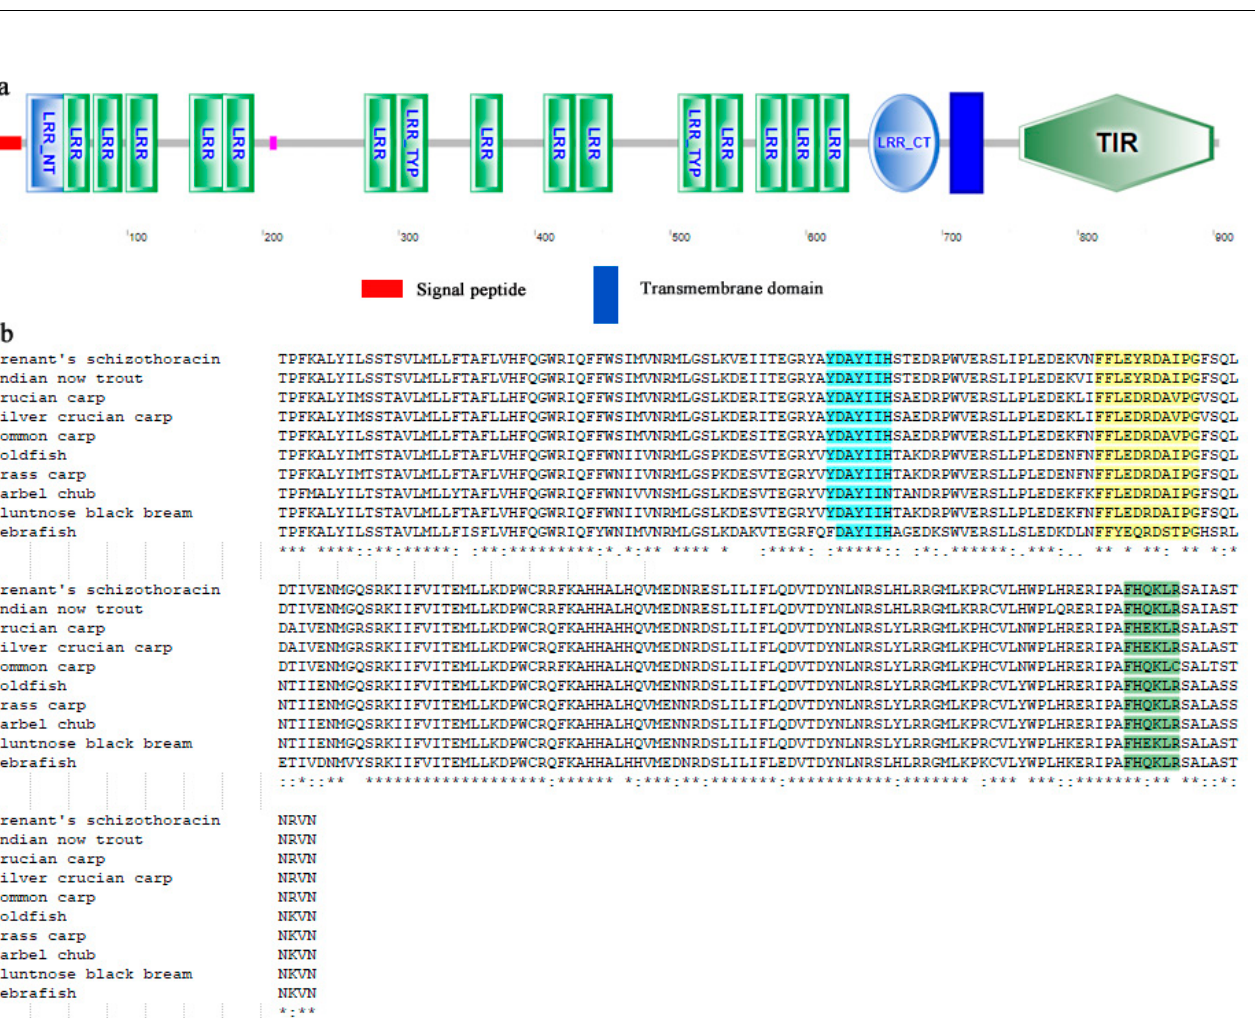
Figure 2. The predicted domain of Sp TLR3 protein by SMART programs. ( a ) Schematic representation of TLR3 domains predicted; ( b ) Multiple alignment of TLR3-TIR domains from different species. Snow trout (GenBank accession no. AGJ74274), Crucian carp (GenBank accession no. AGO57935), Silver crucian carp (GenBank accession no. AGR53439), Carp (GenBank accession no. AHE74142), Goldfish (GenBank accession no. ABC86865), Grass carp (GenBank accession no. ABI64155), Barbel chub (GenBank accession no.ALO75529), Bluntnose black bream (GenBank accession no. ABI83673) and Zebrafish (GenBank accession no. AAI07956). Asterisk (*), identical; colon (:), conserved; and dot (.), semi-conserved residues. The conserved box1 is shown in blue, the conserved box2 is shown in yellow and the conserved box3 is shown in green.